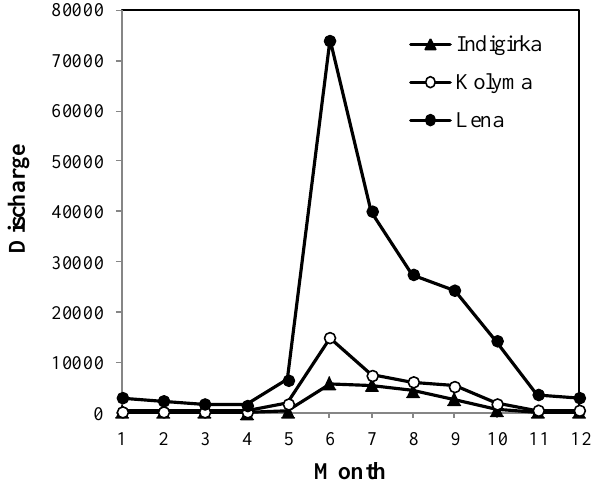
Fig. 1. Monthly average river discharge (m 3 s − 1 ) of the three rivers that dominate the runoff input to the East Siberian